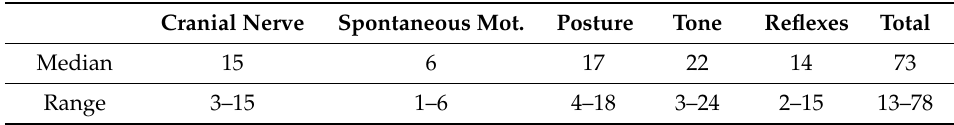
Table 1. HINE scores in total